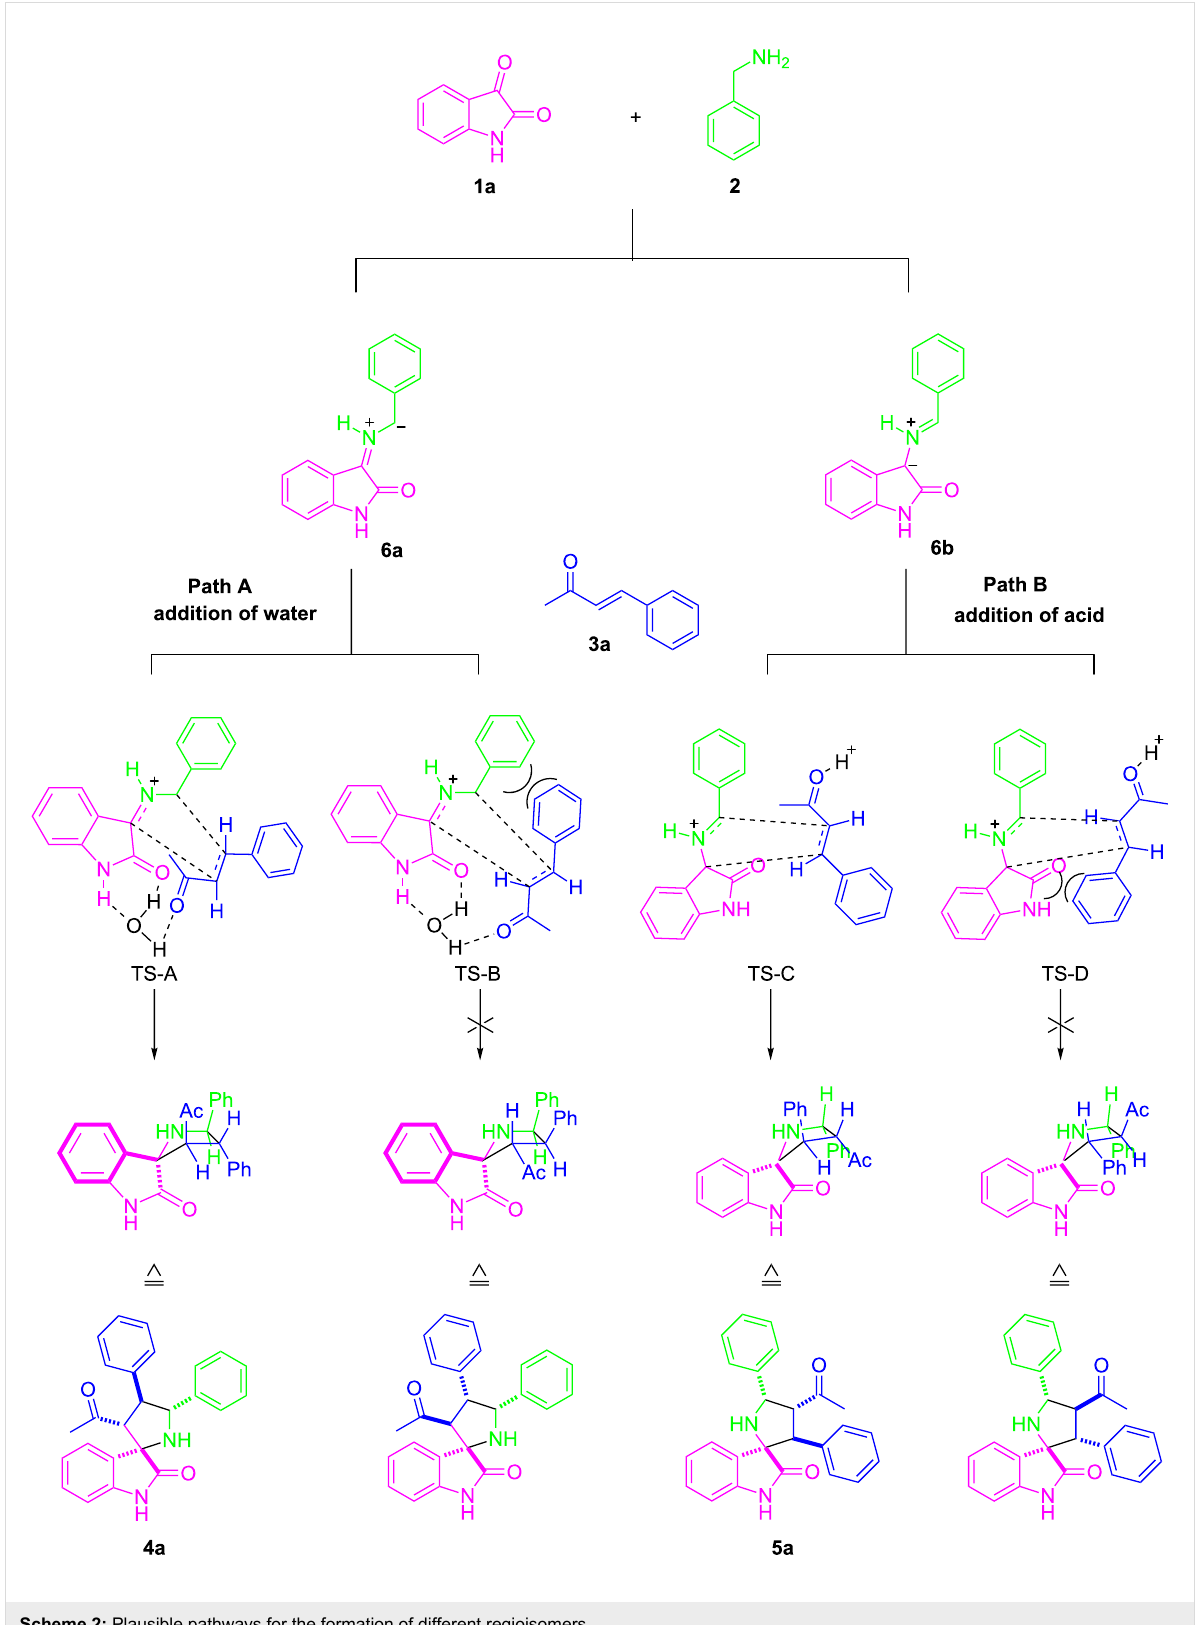
Scheme 2: Plausible pathways for the formation of different